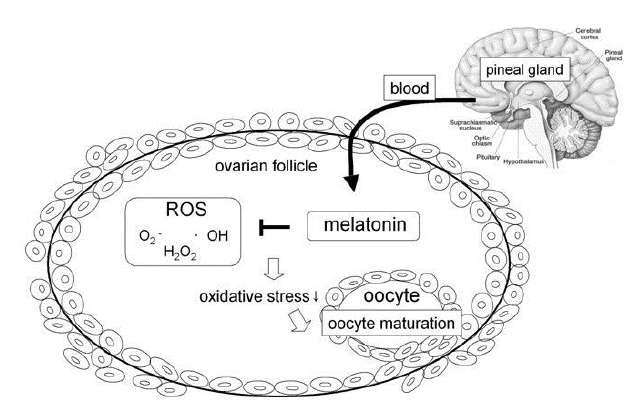
Figure 1 . Role of melatonin as an antioxidant in ovarian antral follicle (57). This figure was published by BioMed Central Ltd/ part of Springer